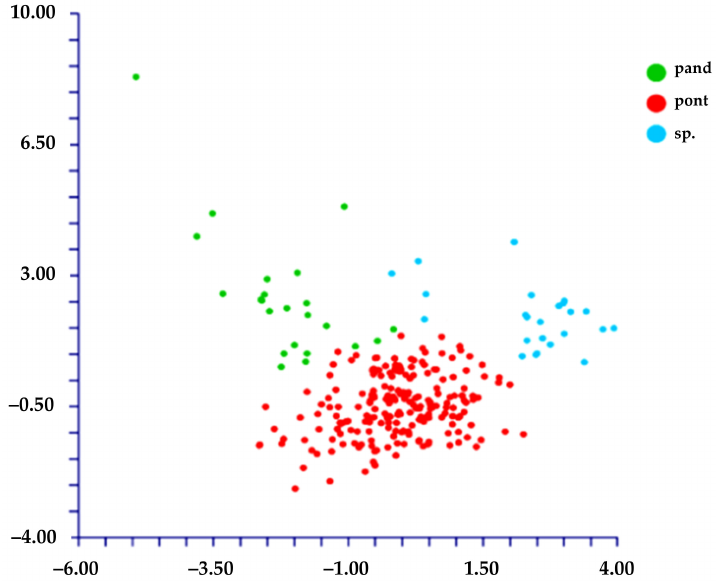
Figure 8. DA [first ( x axis) vs. second ( y axis) components) performed on groups derived from PCA (pand = L. pandatariae ; pont = L. pontium (including L. circaei and L. amynclaeum ); sp. = Terracina